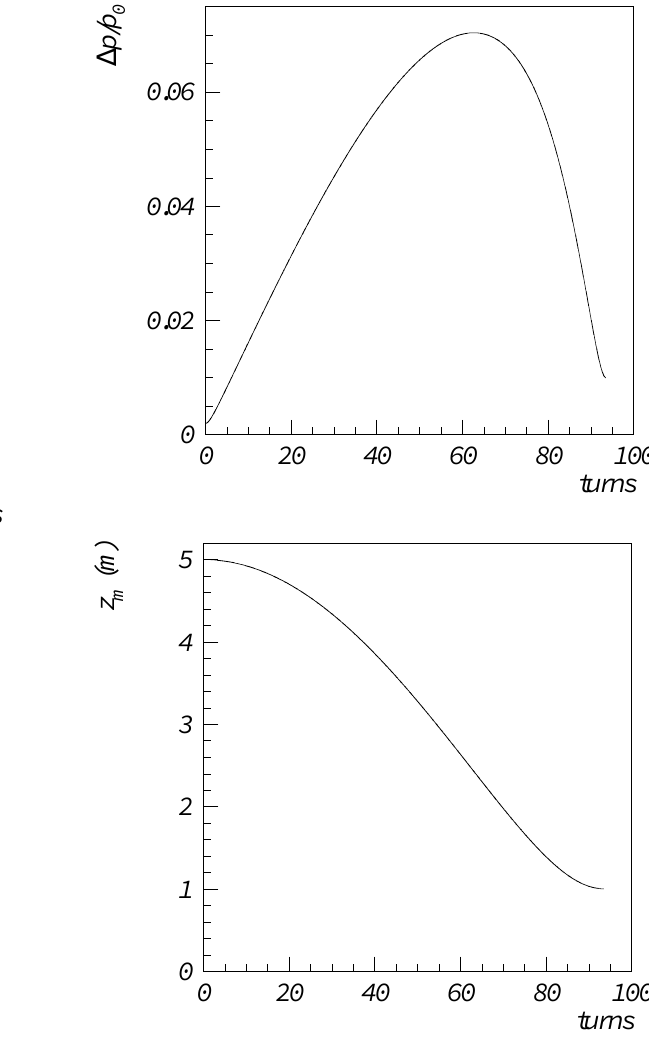
FIG. 4. Momentum spread and envelope for case (ii), with h (cid:1) 2 0.001